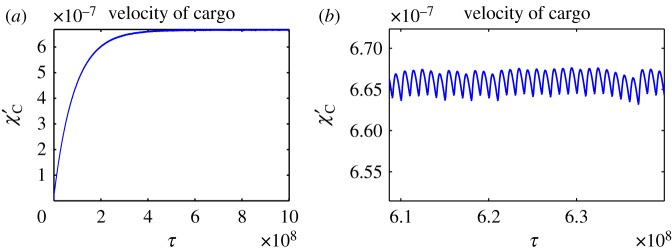
Numerical solutions to the model equations (4.17)–(4.23) with maximum separation between MTBDs at 48 nm and the probability that MTBD E steps at 50%, with end time τFinal = 109 and N = 1000. (a) Velocity profile of the cargo for τ ∈ [0, 109]. (b) Velocity profile of the cargo for a representative subinterval illustrating the long-time dynamics of the cargo.